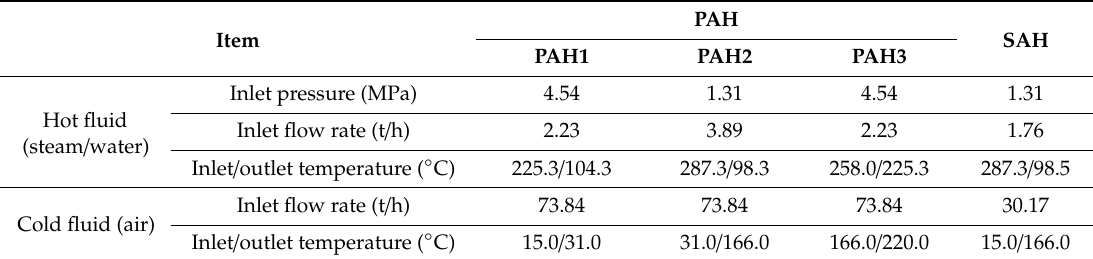
Table 3. Parameters of the air preheating system in the reference WtE plant. PAH: primary air heater and SAH: secondary air